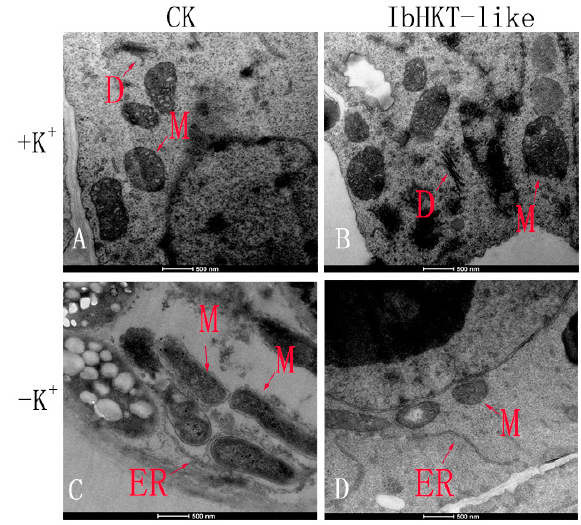
Figure 3. Effects of K + deficiency on the ultrastructure of root tip cells ( A ) Ultrastructure on root tip cells of CK under control treatment. ( B ) Ultrastructure on root tip cells of overexpressing IbHKT-like under control treatment. ( C ) Ultrastructure on root tip cells of CK under potassium deficiency treatment. ( D ) Ultrastructure on root tip cells of overexpressing IbHKT-like gene under potassium deficiency treatment. +K + : 10 mmol · L − 1 K + treatment; − K + : 0 mmol · L − 1 K + treatment; CK: CK plants; IbHKT-like : transgenic root plants overexpressing IbHKT-like gene; ER: Endoplasmic reticulum; D: Golgi dictyosomes; M: Mitochondria. Bar = 500 nm ( × 11,000).